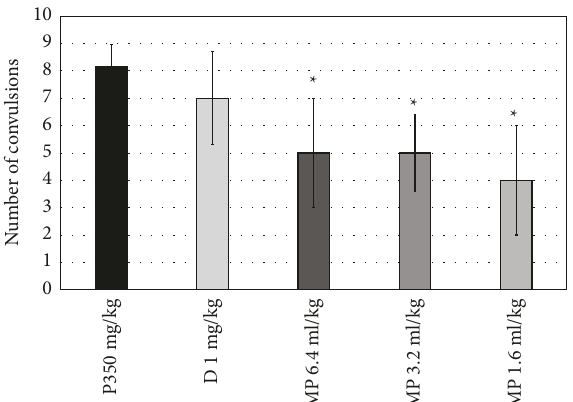
Figure 2: Effects of MPO (6.4, 3.2, and 1.6ml/kg) on the number of convulsions in the pilocarpine-induced epilepsy model in mice, ∗ P < 0 . 5 when compared to the P350 group.